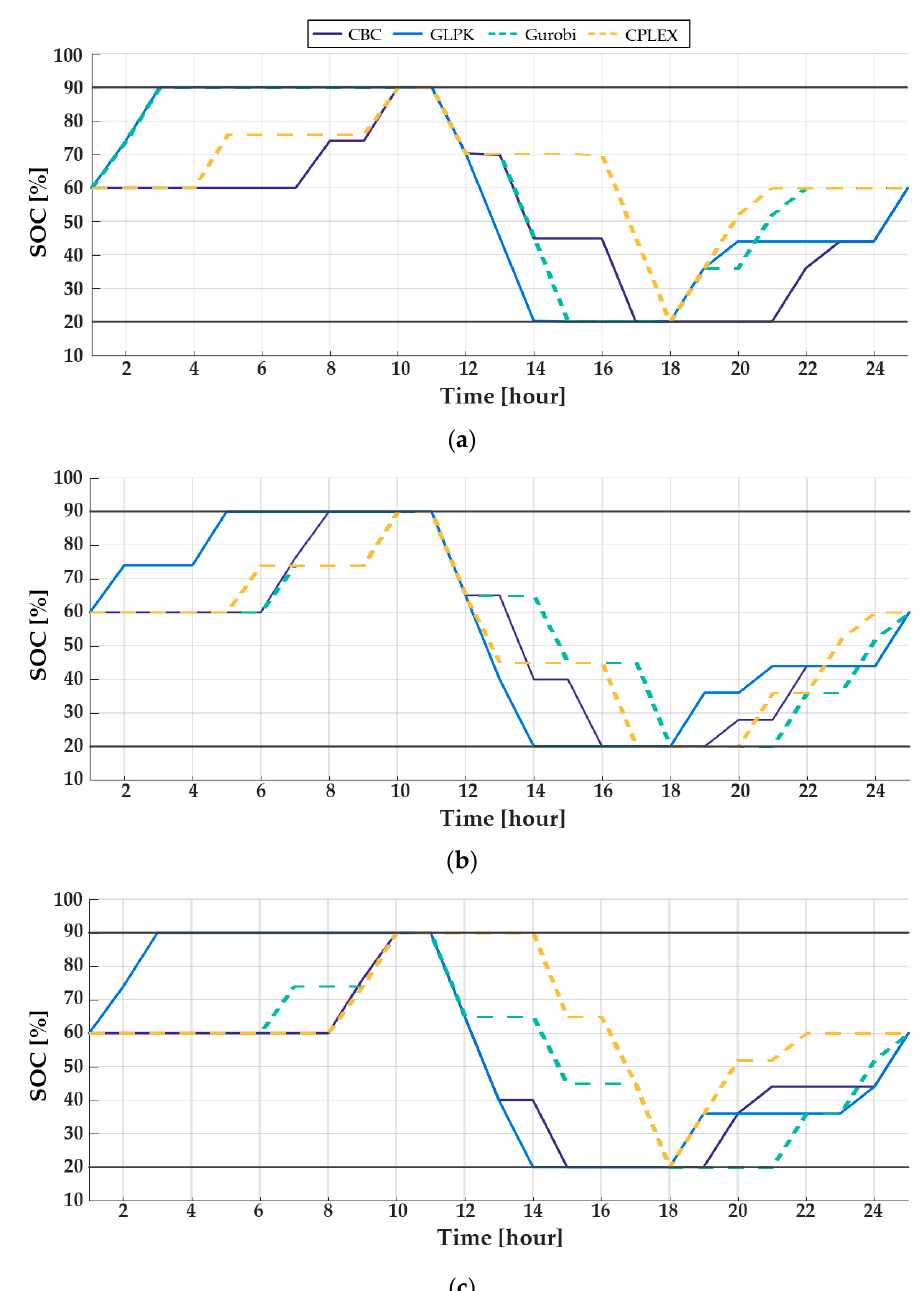
Figure 9. Variation of the the state-of-charge (SOC) levels corresponding to the scheduled ESS power. ( a ) case 1:6 bus system; ( b ) case 2:33 bus system; ( c ) case 3:123 bus system.